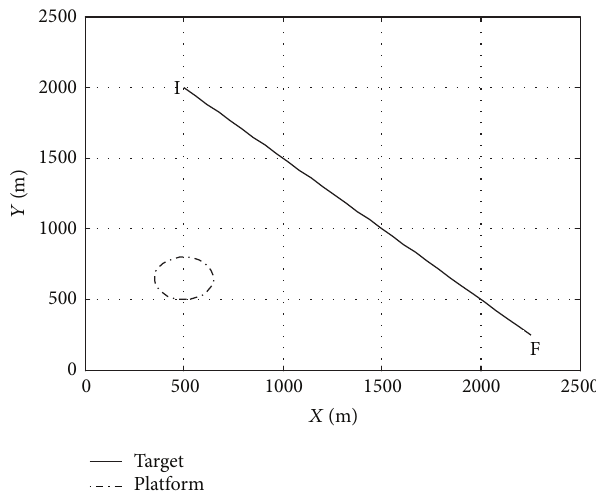
Figure 2: Target trajectory (I-initial position and F-final position) and sonar